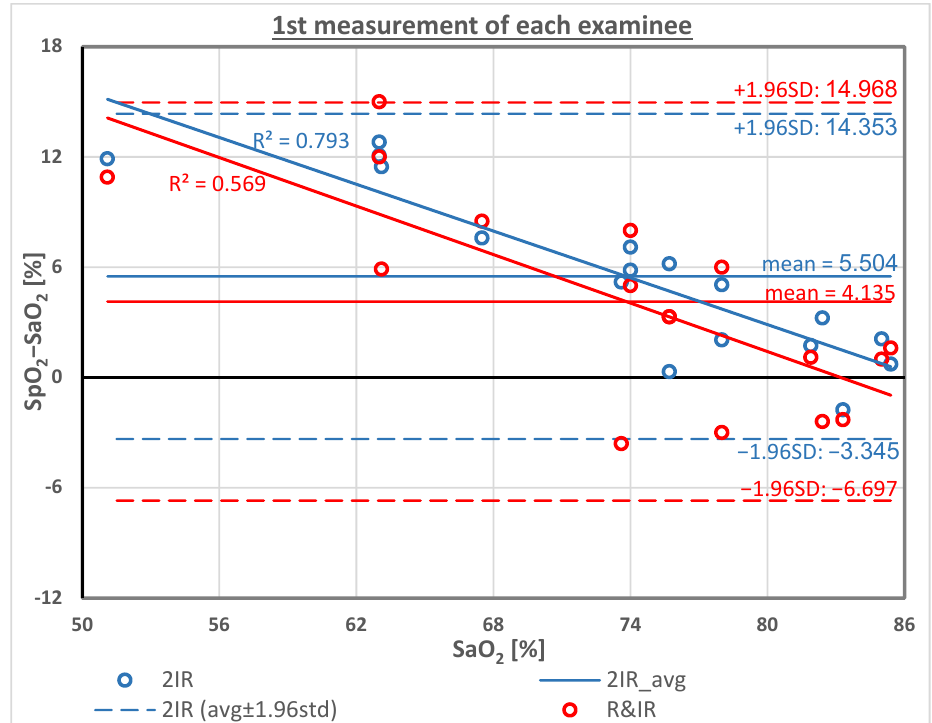
Figure 4. Modified Bland-Altman plot: SpO 2 − SaO 2 as a function of SaO 2 for the two SpO 2 mea- surement techniques. SpO 2 − SaO 2 is small for SaO 2 above 80% but is about 12% for low values of SaO 2